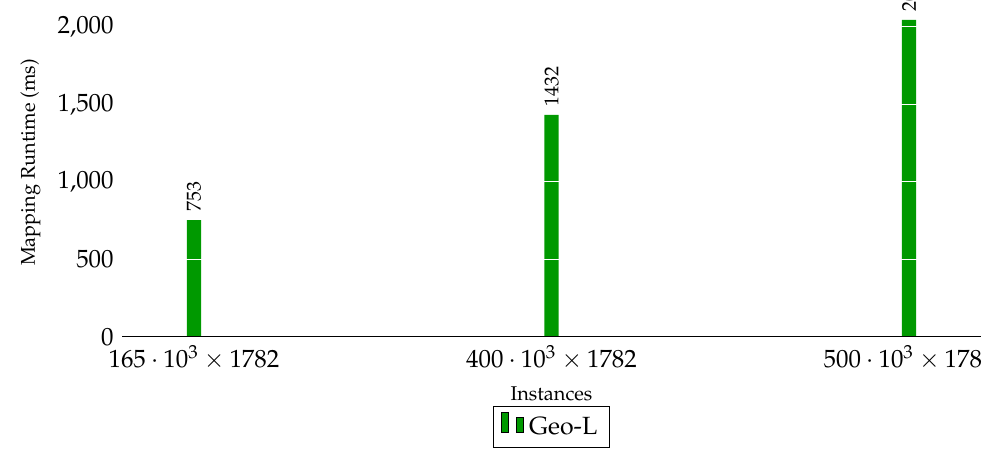
Figure 6. Performance SPOI–NUTS; topological relation: